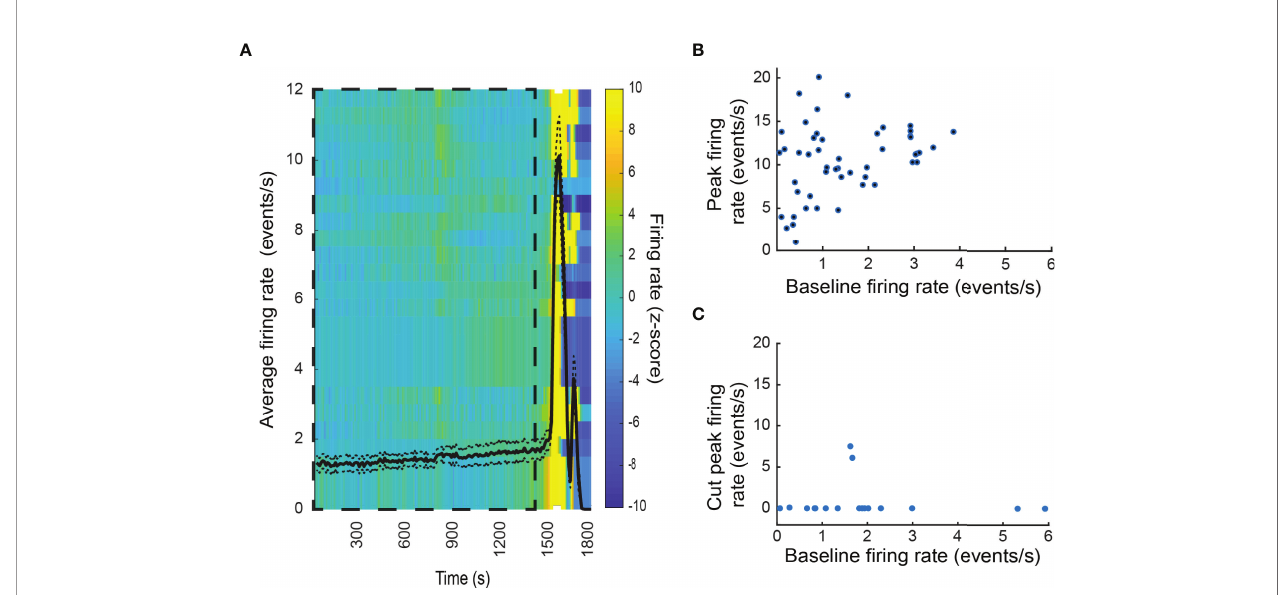
FIGURE 7 | Physiological stress response to respiratory arrest in the intact adrenal medulla. (A) Generalized increase in the fi ring rate of the chromaf fi n cells was observed at the moment of respiratory arrest due to anesthesia overdose. Shown are the results of an individual experiment. Firing rates from 25 cells were analyzed. The black line corresponds to the average fi ring rate over time ± SEM (left axis). A normalized fi ring rate (Z-score) over time for each unit (row) is indicated by the color code (right axis). The baseline period is indicated by the dashed box. (B) Relation between the baseline fi ring rate and the peak fi ring rate after respiratory arrest. The combined results from three experiment are presented. The frequency 47 of 48 units increased following respiratory arrest. (C) Denervation virtually abolished the increase in fi ring rate upon respiratory